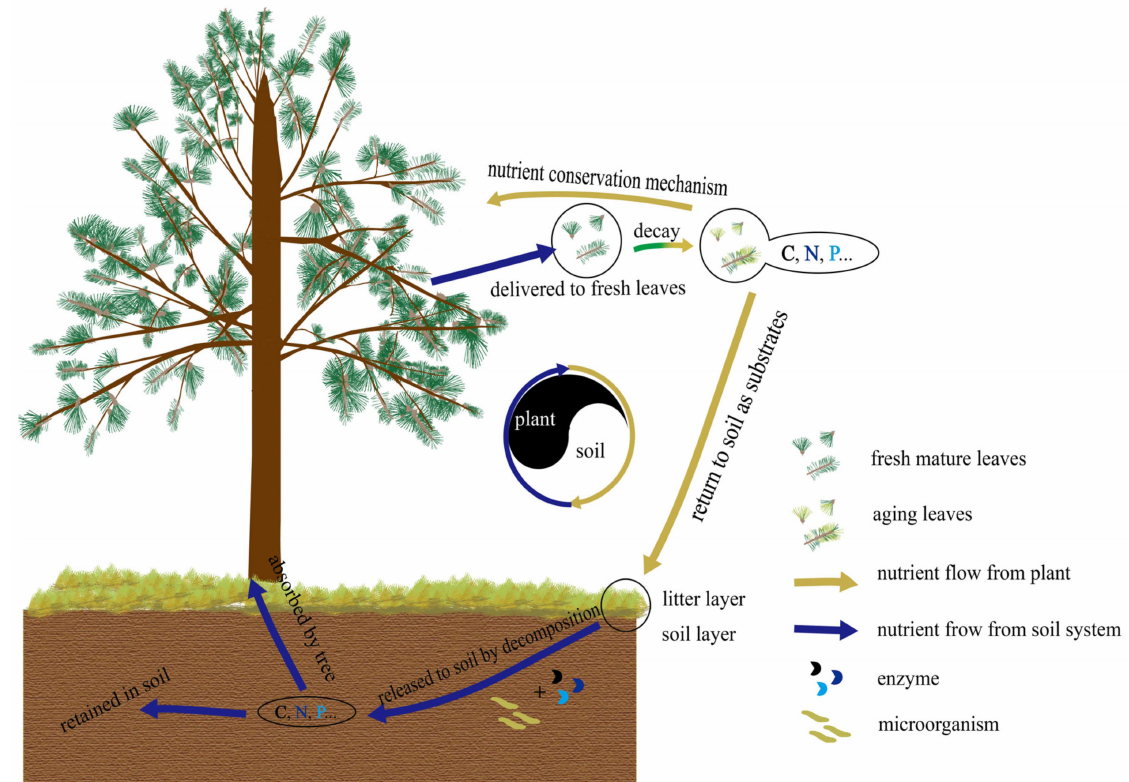
Figure 1. Graphs of element exchange between plant and soil in our